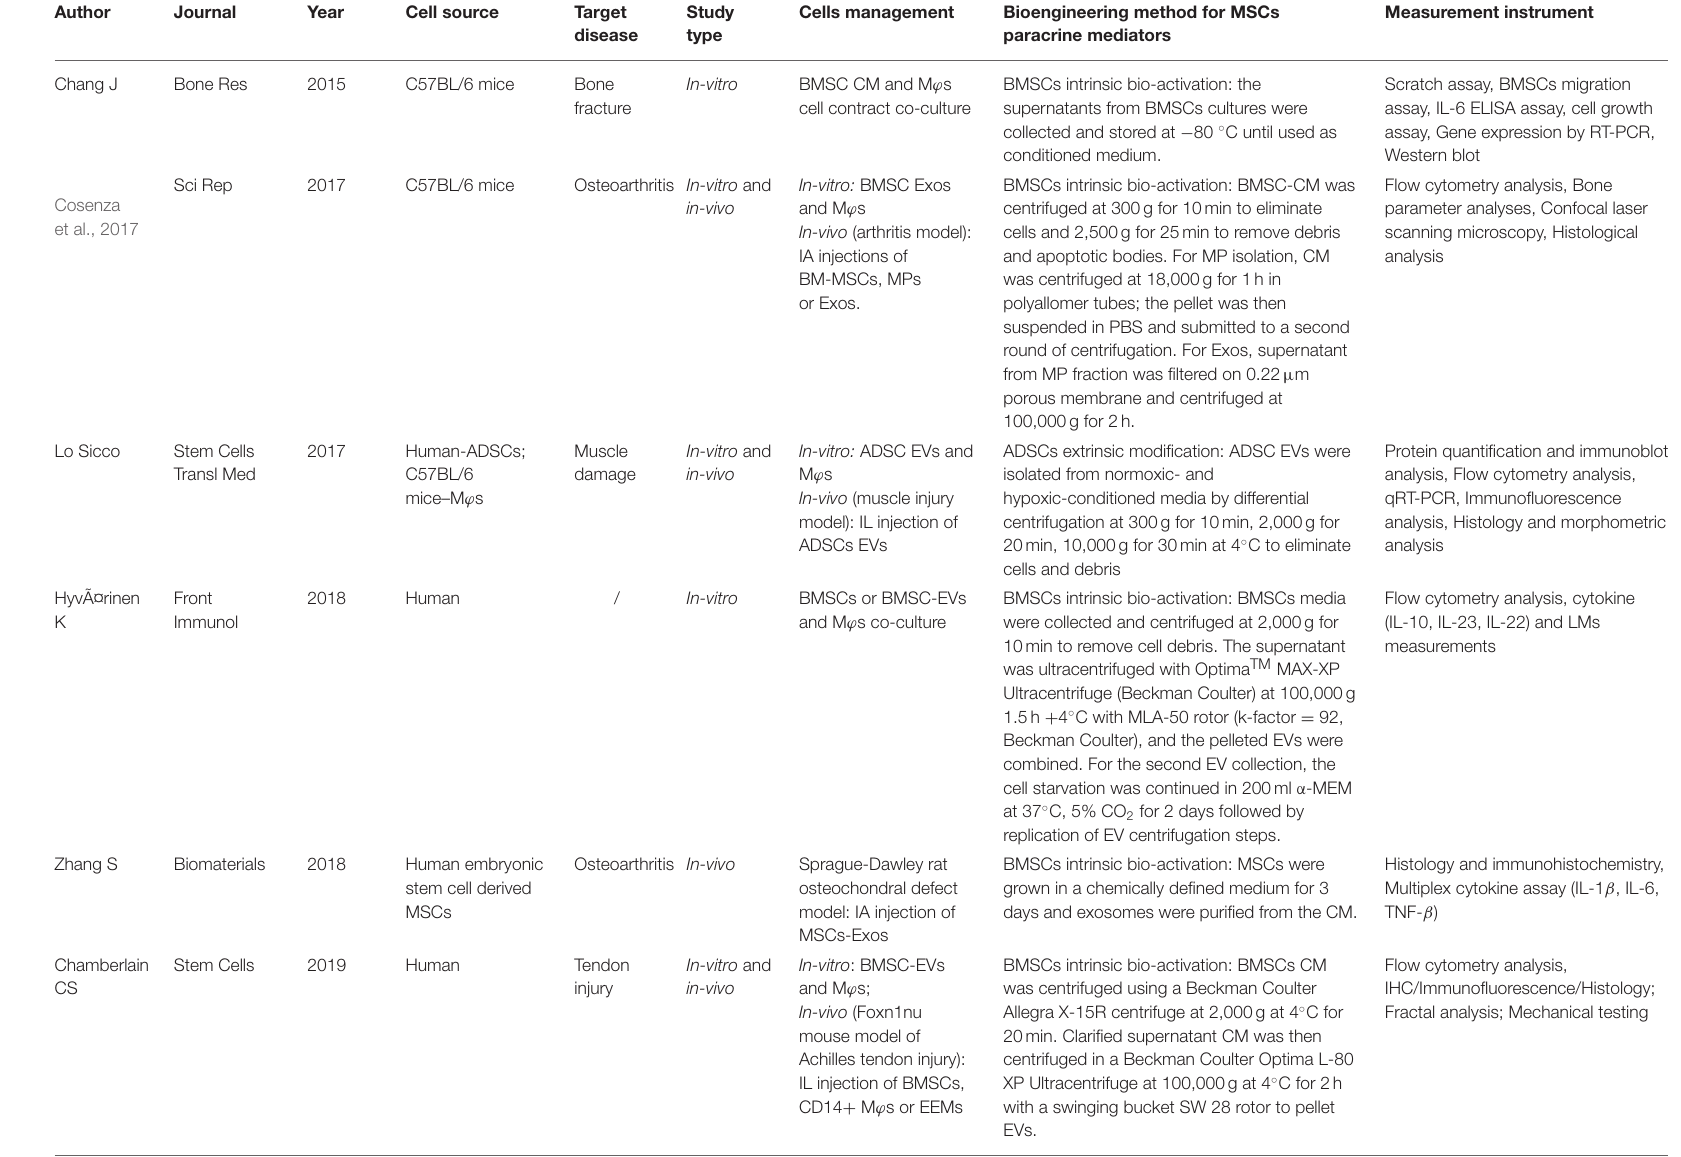
TABLE 2 | Study characteristics and